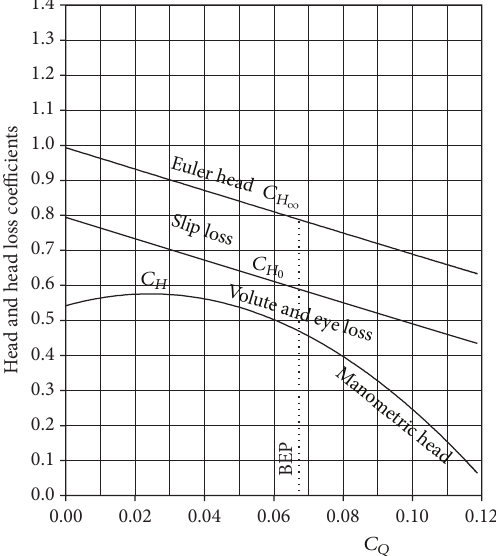
Figure 13: Variation of head coefficients and head loss coefficients with discharge